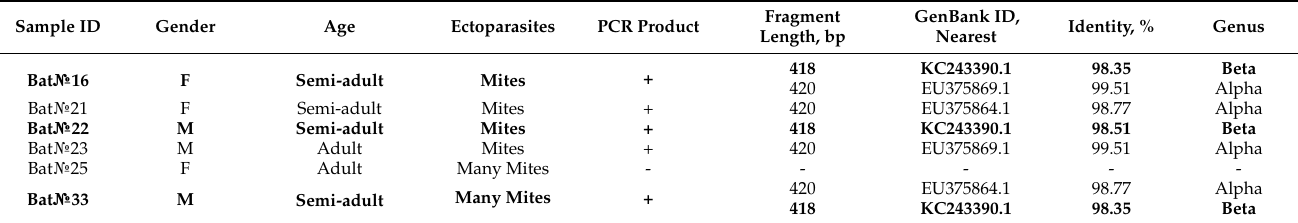
Table 1. P. nathusii in which natural coronavirus infection was investigated. Samples where β -CoVs were detected are marked in